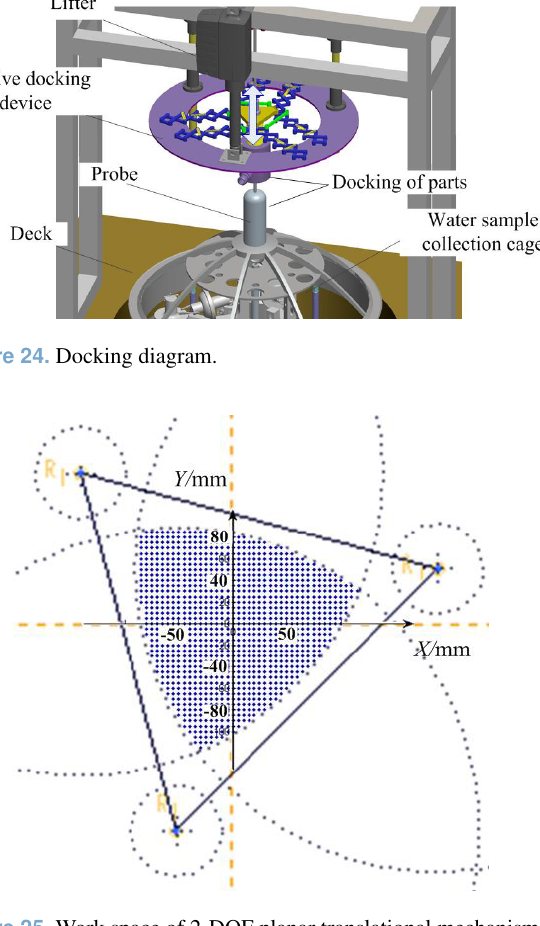
Figure 25. Work space of 2-DOF planar translational